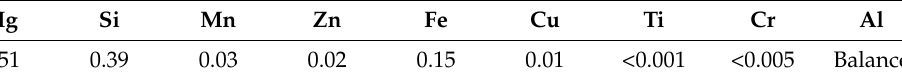
Table 1. Chemical composition of the 6063 aluminium alloy (wt.%).